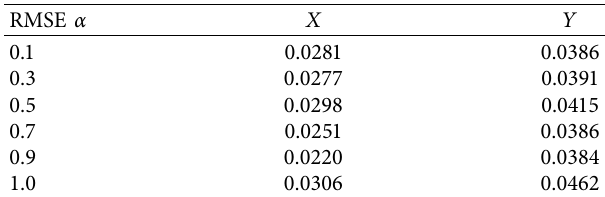
Table 1: RMSE of x -axis and y -axis under different fractional orders and integer